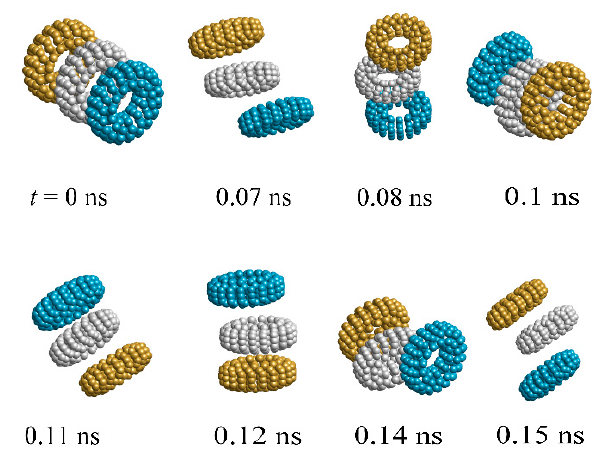
Figure 5. Demonstration of the effect of rotating clusters of three nanotori.